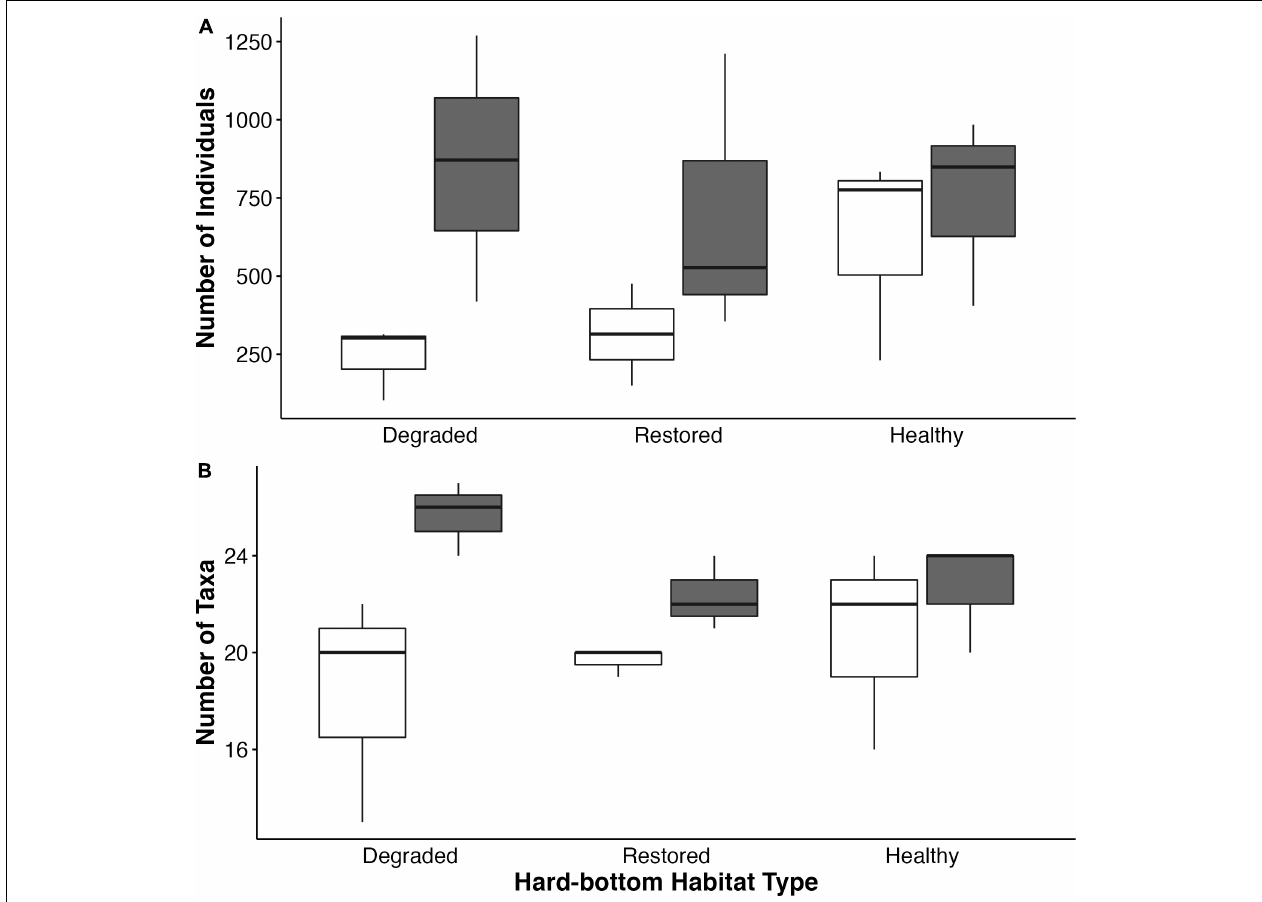
FIGURE 2 | Boxplots of larval collections within the three hardbottom types. Number of larval fish and invertebrates (A) and number of larval fish and invertebrate taxa (B) that settled on larval shag collectors during full moon (white) or new moon (gray) deployed at three types of hardbottom sites: degraded, restored, and healthy.